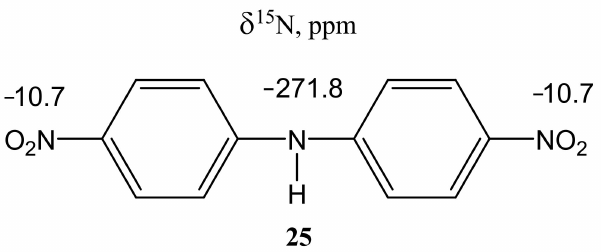
Figure 3. 15 N NMR chemical shifts of bis( para -nitrophenyl) amine ( 25 ) (ppm) (DMSO- d 6